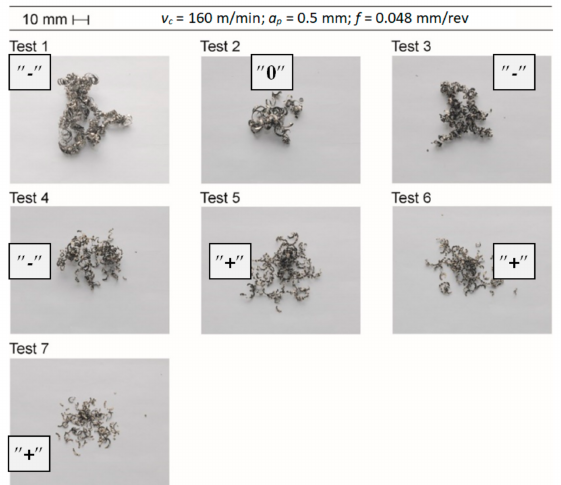
Figure 21. Photographs of chips for v c = 160 m/min (change of chip form), “-” = unacceptable chips with a length of more than 150 mm; “0” = acceptable chips with a length of 20–150 mm, and favorable chips “+” = with a length of up to 20